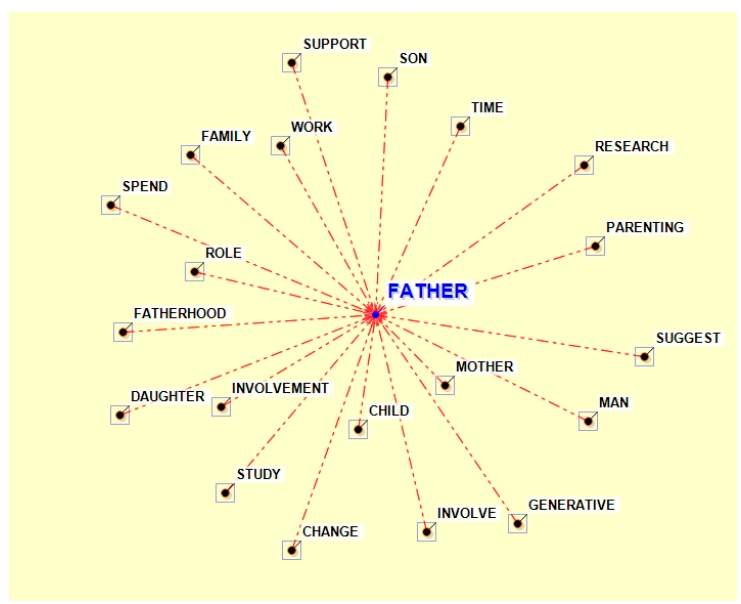
Figure 1. Radial diagram with “father”.